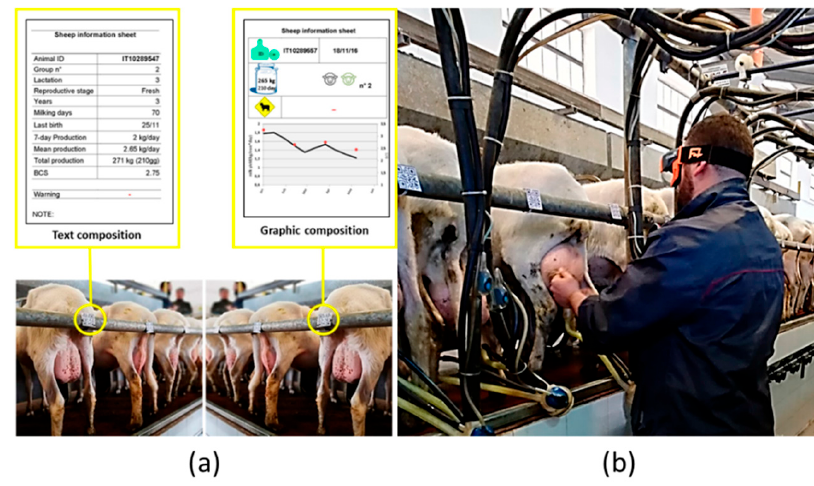
Figure 11. ( a ) Sheep information in text and graphic format and ( b ) a participant reading information regarding an animal on GlassUp F4 smart glasses (F4SG) while milking [69].